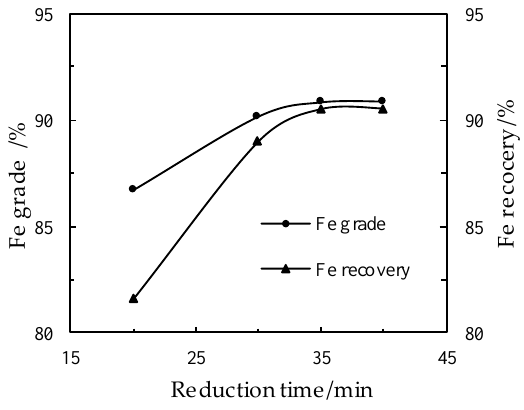
Figure 6. Effect of reduction time on the DR process.